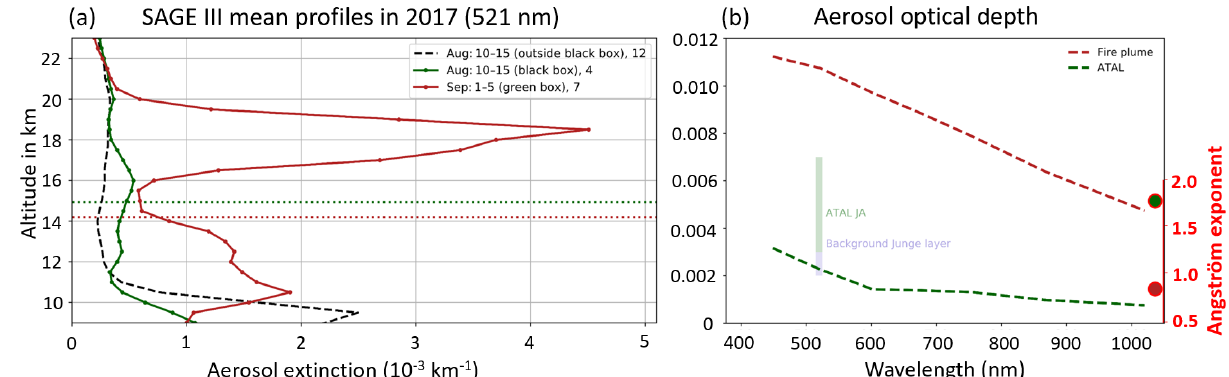
Figure 2. (a) Mean SAGE III aerosol extinction profiles in the UTLS at 521nm in defined areas: the green curve shows the average for the black box from Fig. 1a, from 10 to 15 August. The black curve is the equivalent mean extinction profile for the area 15–45 ◦ N and 60 ◦ W– 10 ◦ E. The red curve shows the average for the green box in Fig. 1a from 1 to 5 September. Tropopause heights given by the SAGE III data set are indicated (dotted green line: ± 2 . 7km; dotted red line: ± 2 . 3km). The number of profiles averaged is indicated. (b) Spectral AOD from SAGE III observations for the mean fire and ATAL (dashed red and green lines, respectively). The intervals of CALIOP AODs at 550nm for the July–August (JA) ATAL and Junge layer are also displayed (semi-transparent green and blue, respectively) – Vernier et al. (2015). Dots indicate the Ångström exponent for the fire (red) and ATAL